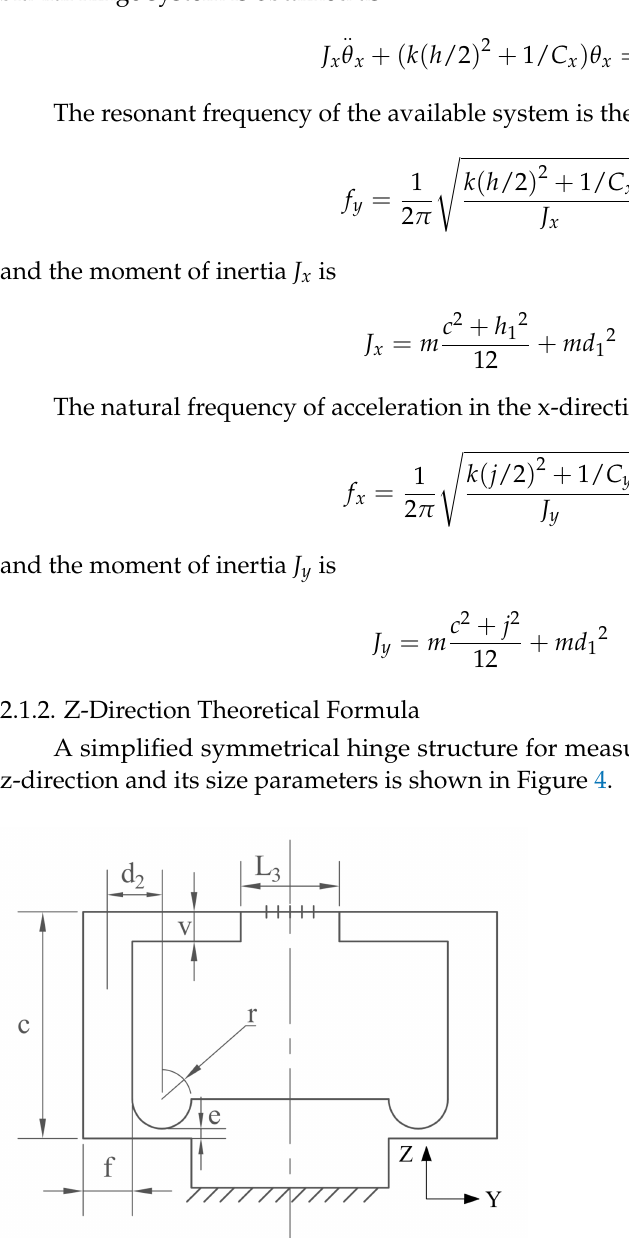
Figure 4. Simplified schematic of z-direction